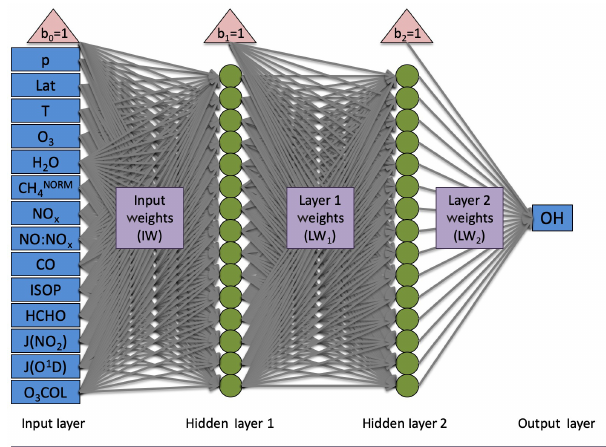
Figure 1. Architecture for neural networks generated in this study. Blue boxes designate inputs (left) and output (right), red triangles indicate bias terms, green circles indicate nodes at which activation functions are performed, and grey arrows represent the weighting terms, which are optimized through the training process. For full details of the neural network setup and training, we refer readers to Nicely et al. (2017). Although 15 nodes are shown here in each hidden layer, 30 were actually used for all NNs in this